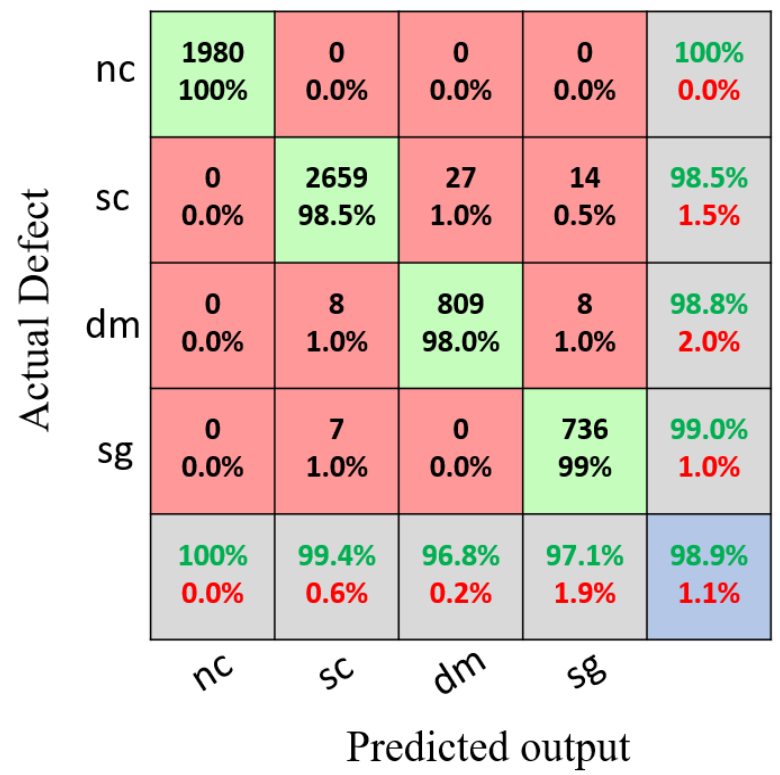
Figure 14. Results of the confusion matrix for the multivariant defects and non-crack concrete using the testing set.